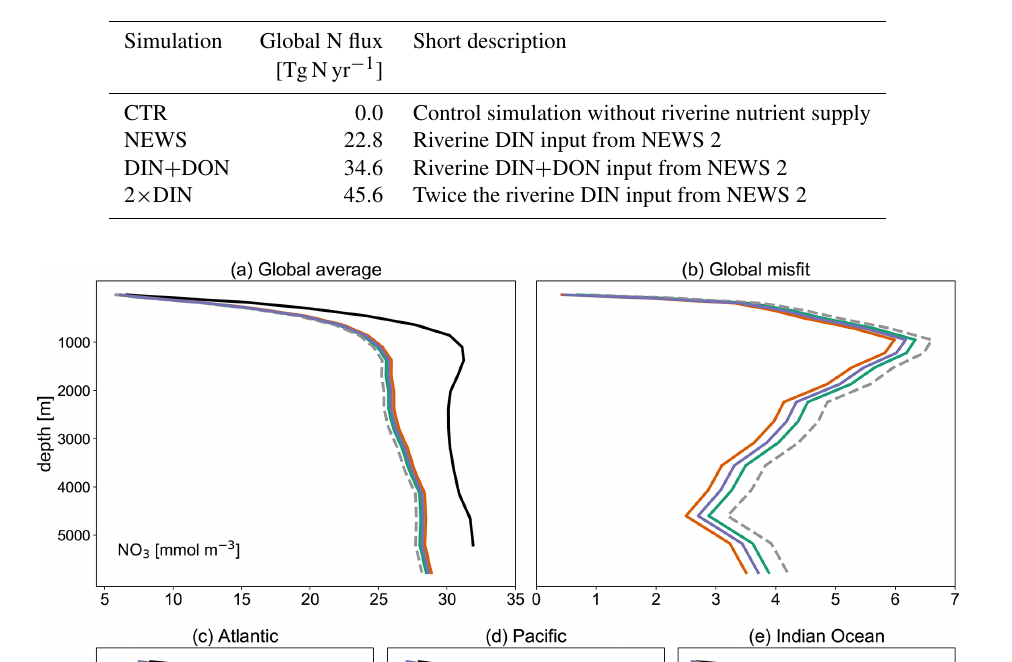
Table 1. UVic simulations and global annual nutrient flux from river discharge from Global Nutrient Export from WaterSheds 2 (Mayorga et al., 2010).